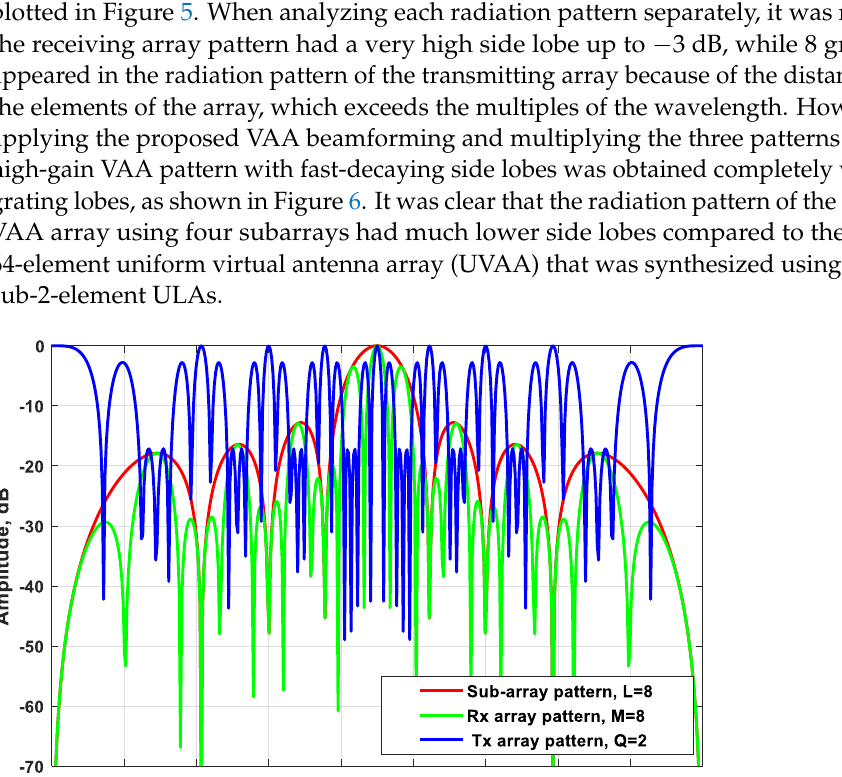
Q = 2, P = 2, L = 8, and d s = d = λ 𝑄 = 2 , 𝑃 = 2, 𝐿 = 8, and 𝑑